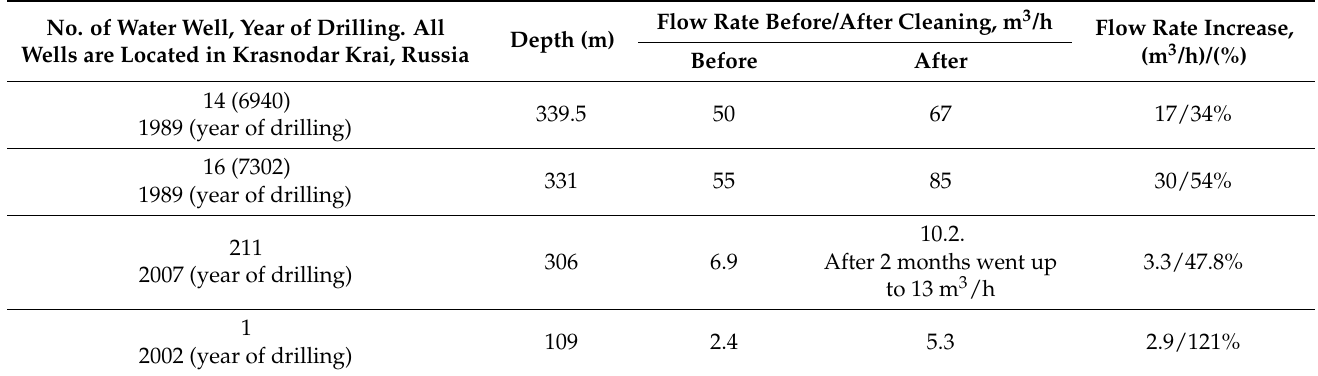
Figure 14. Well rehabilitation operations: ( a ) cleaning setup, ( b ) mixture pumped out of the well during the cleaning, ( c ) submerged nozzle holder on high-pressure hose.